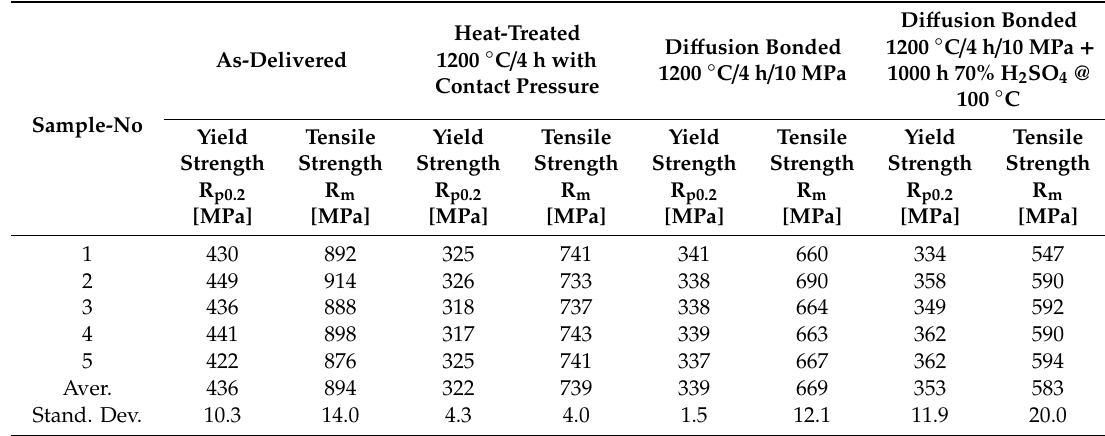
Table 7. Mechanical properties of Hastelloy BC-1 in di ff erent conditions. ( A ) Yield strength and tensile